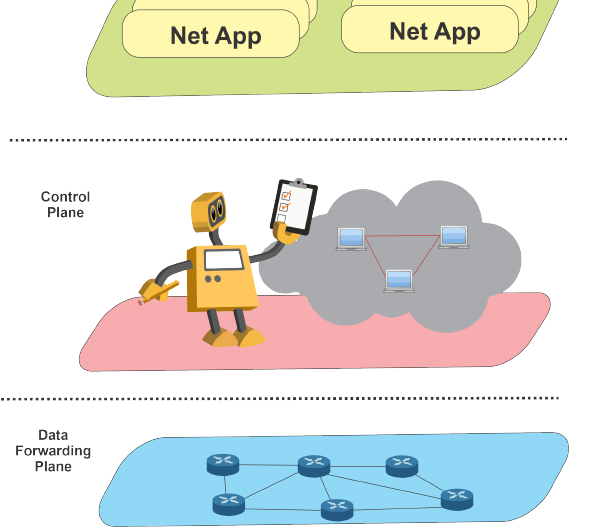
Figure 2. Software-Defined Network architecture presents three planes: data forwarding, control, and